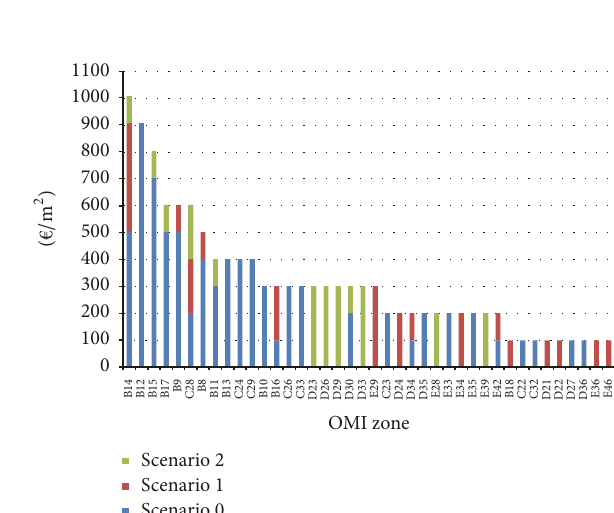
Figure 13: Scenarios.